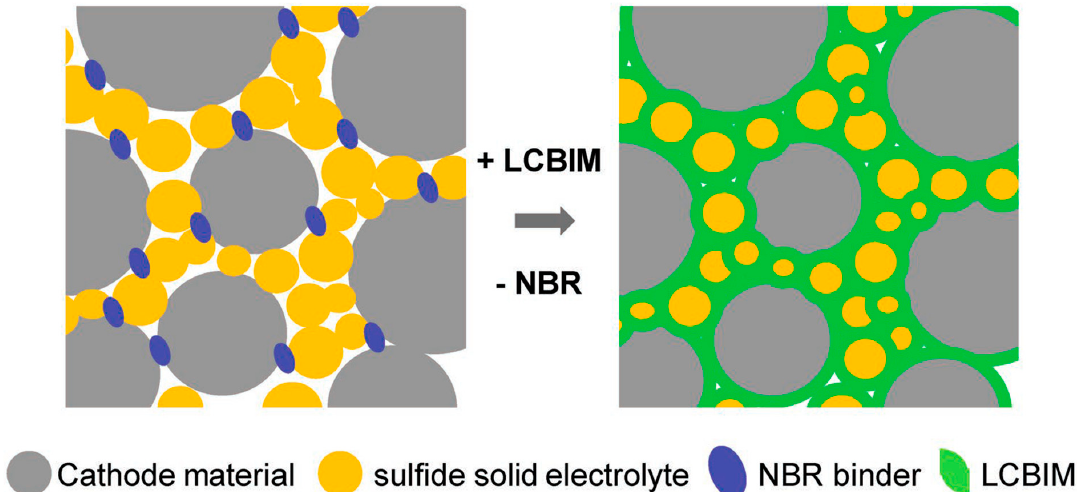
Figure 8. Schematic diagram representing the microstructure of the composite electrodes with polymer gel electrolyte (LCBIM), showing that LCBIM improves the interfacial contact area with conductive and adhesive properties. Carbon additives included in the composite electrode are not shown. Reprinted with permission from Cho et al. [183].